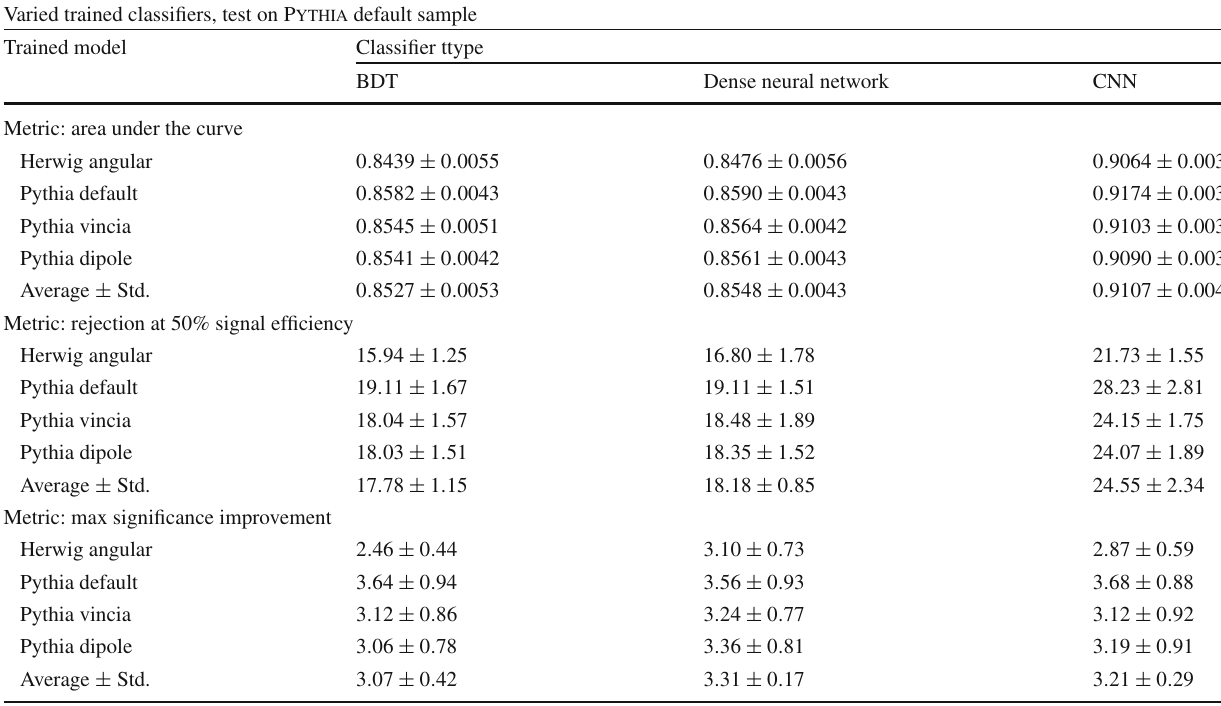
Table 2 Area under the curve, rejection at 50% signal efficiency and maximum significance improvement when testing on Pythia default for each trained classifier. The last rows are the average and standard deviation over the mean values from the other rows Varied trained classifiers, test on Pythia default